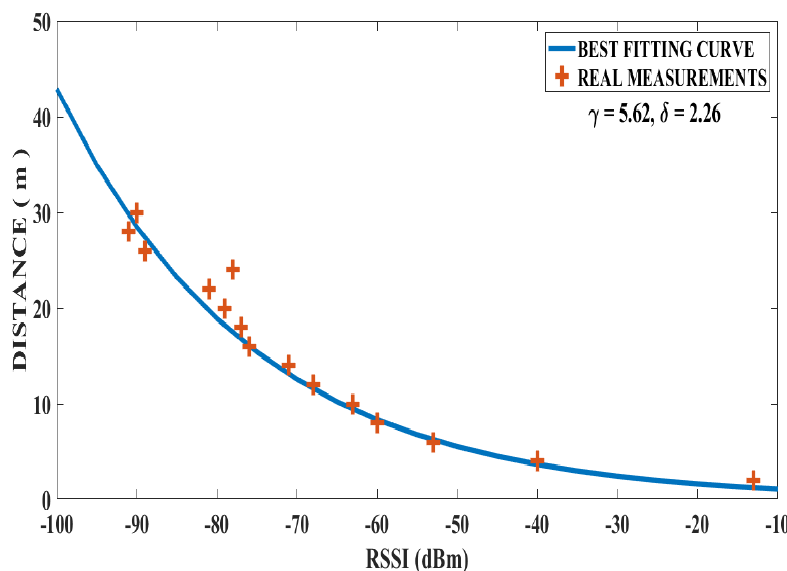
Figure 19. Pathloss exponent for device 1 deduced using best fitting curve.